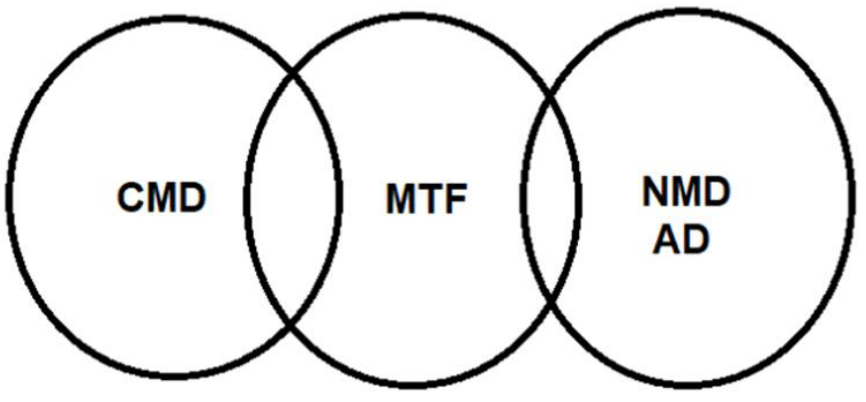
Figure 6. Metabotrophic factors on the crossroad of cardiometabolic diseases (CMDs) and